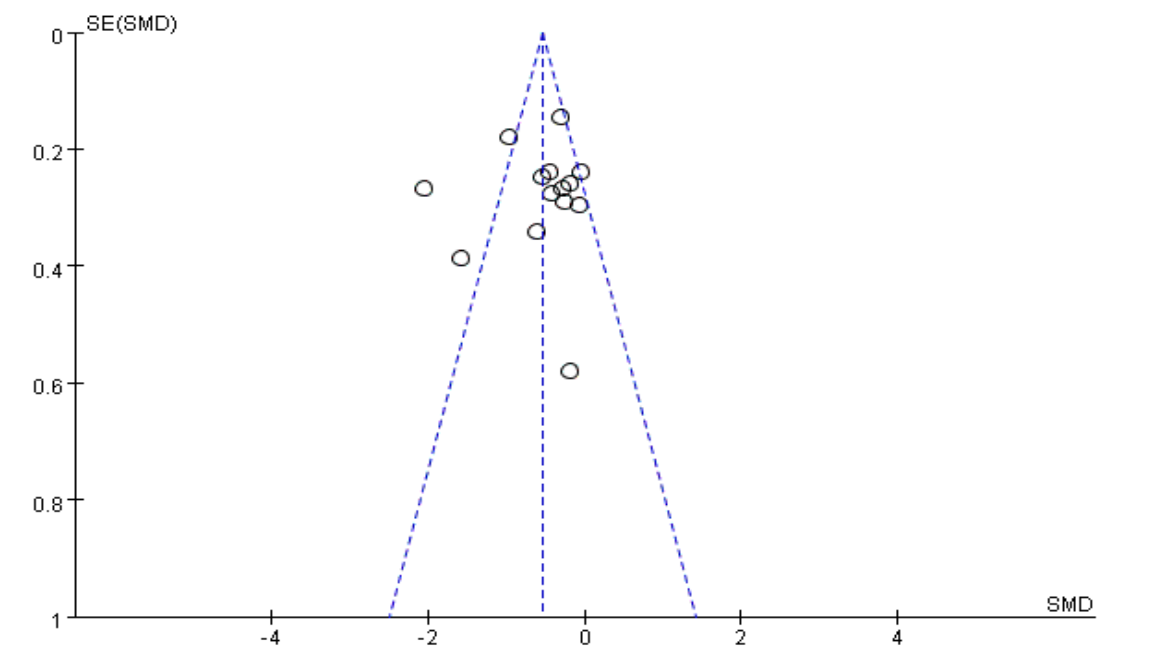
Figure 3. funnel plot showing the results for sleepiness. Figure 3. Funnel plot showing the results for sleepiness.